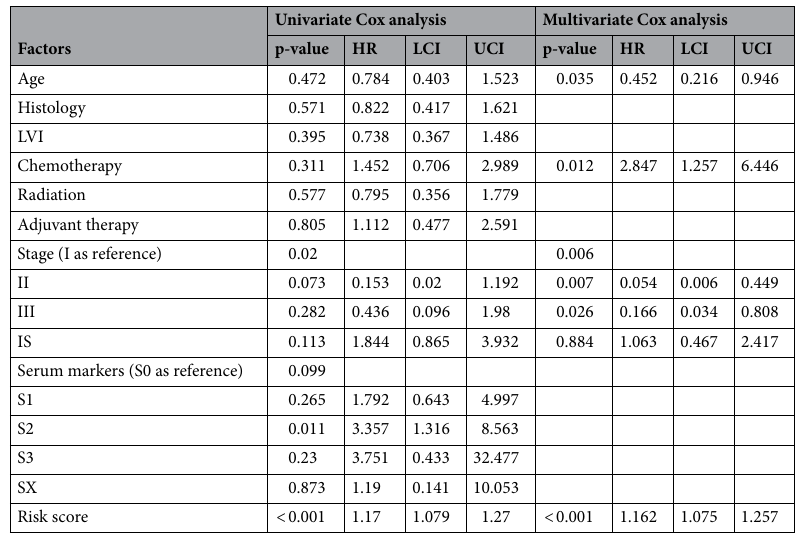
Table 3. Univariate Cox regression analysis and multivariate Cox regression analysis outcome based on methylation risk score and other clinical factors. HR hazard ratio, LCI lower 95% confidence interval, UCI upper 95% confidence interval, LVI lymphatic vascular